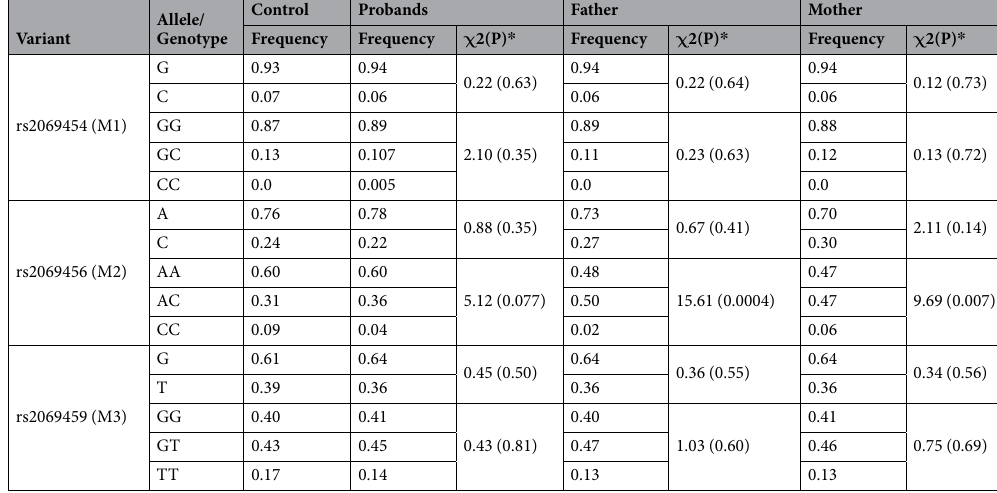
Table 1. Allele and genotype frequency of CDK5 bimorphic variants in the Indo-Caucasoid population. NB. * as compared to